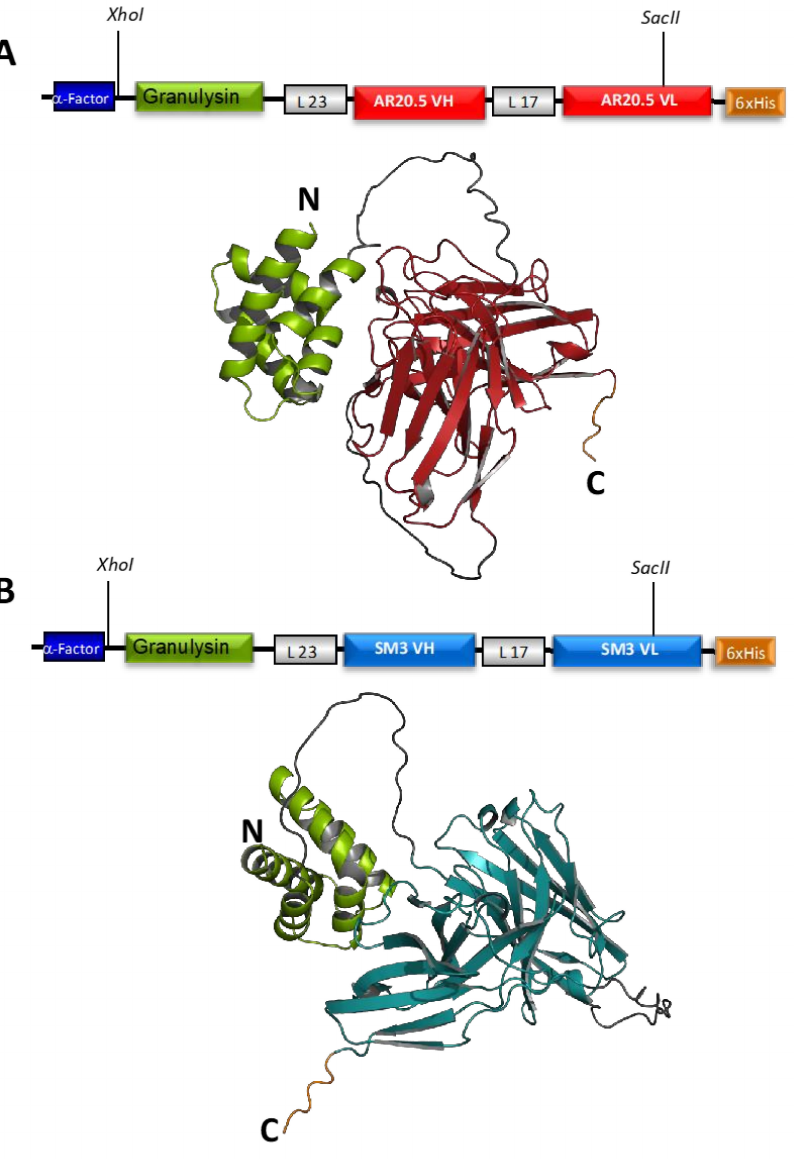
Figure 1. Structural features of immunotoxins. Plasmid constructution and Alpha-Fold structural model of the chimeric protein of the ( A ) immunotoxin AR20.5GRNLY